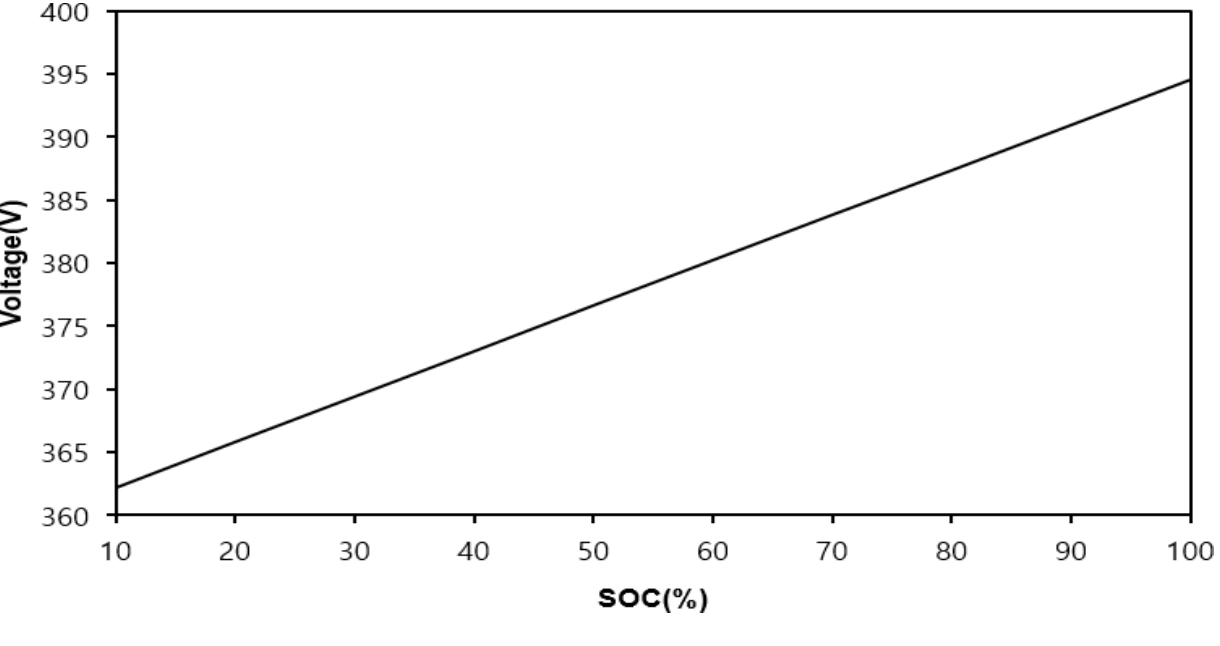
Figure 5. Battery voltage–SOC drop curve.